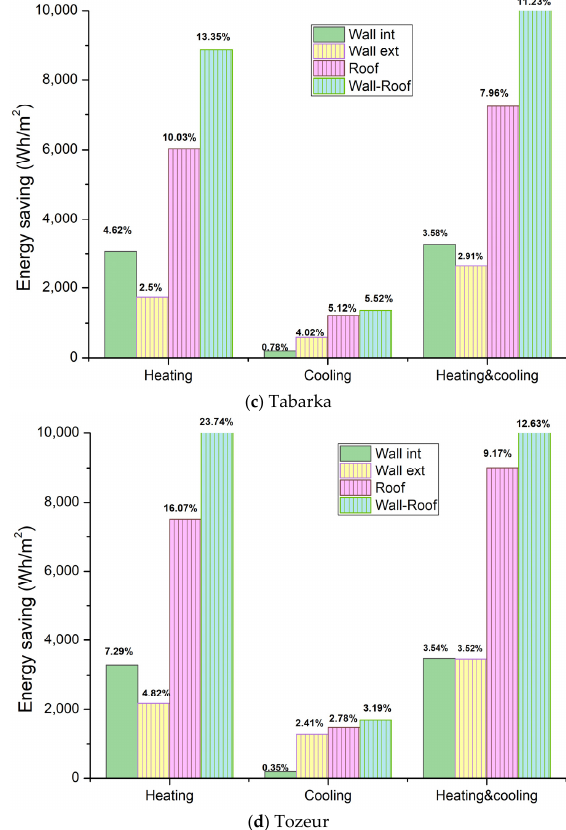
Figure 7. E ff ect of envelope type and PCM location on the energy saving. Figure 7. Effect of envelope type and PCM location on the energy It can be seen from the given fi gure that the utilization of PCM provided signi fi cant energy savings both in heating and cooling applications for all of the considered cities, regardless of the PCM location (Wall int and Wall ext) as well as building envelope type (wall, roof, or wall-roof). The interior location for PCM21 was found to be more bene fi cial in terms of energy saving compared to the exterior location for the heating period. However, on the contrary, the exterior location saved more energy than the interior location for the cooling period. As compared to the traditional building envelopes, the reduction in the heating load reached 16.6%, 23.7%, 14.7%, and 13.6% in Sousse, Tozeur, Bizerte, and Tabarka, respectively, by implementing PCM21 in a wall-roof con fi guration. Although considerable reductions in energy consumption for cooling were achieved, these savings are marginal compared to the amount saved in heating energy. Using PCM in both the internal wall (with higher energy saving) and roof (wall-roof con fi guration) provided the highest energy saving amount irrespective of the city, i.e., climatic region. The least-e ffi cient scenario was a tt ained when the PCM was integrated into the exterior